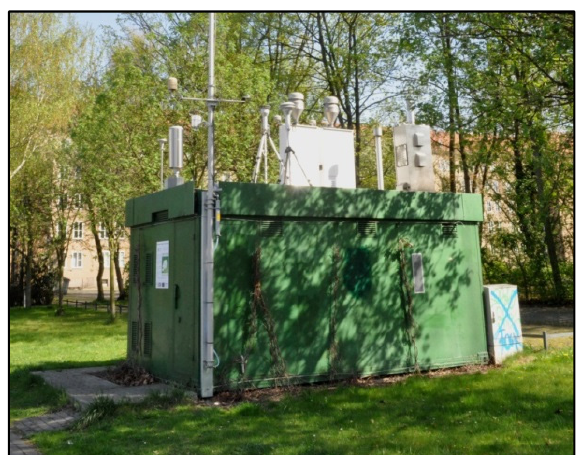
Site 5: Dresden-Winckelmannstr. (urban background)